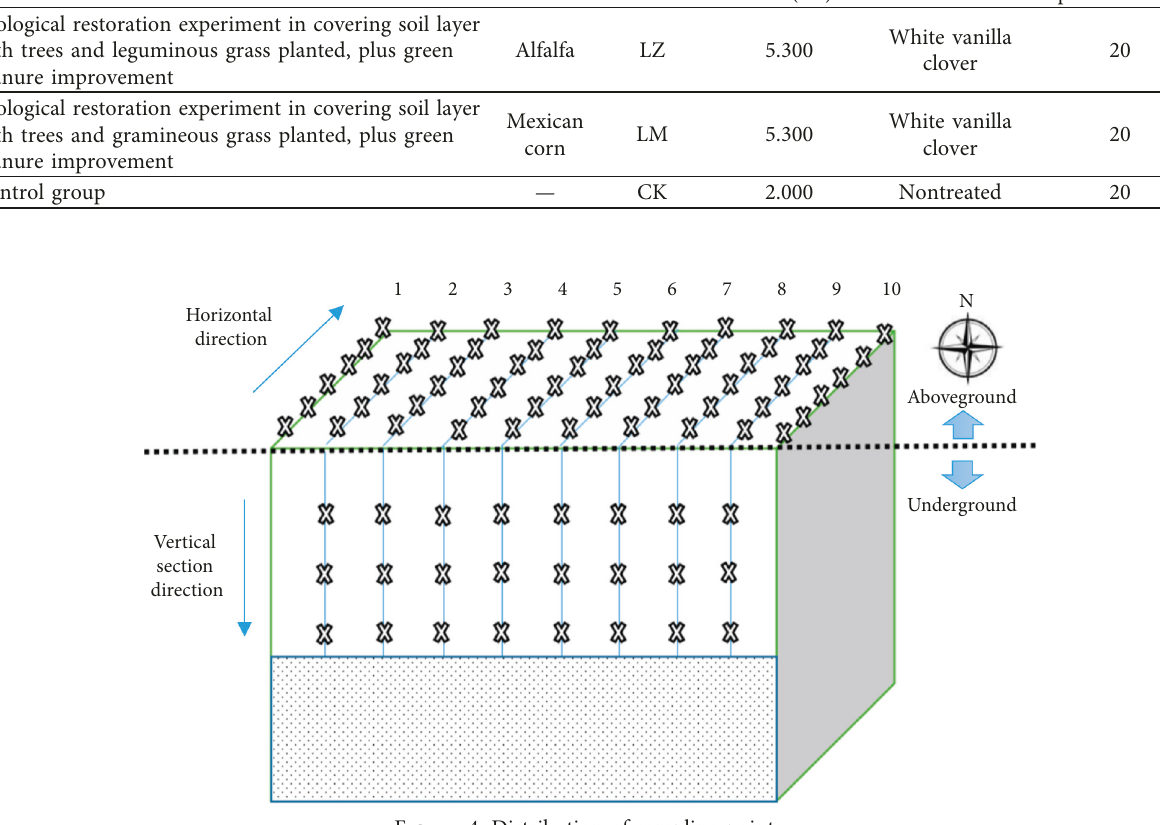
Figure 4: Distribution of sampling